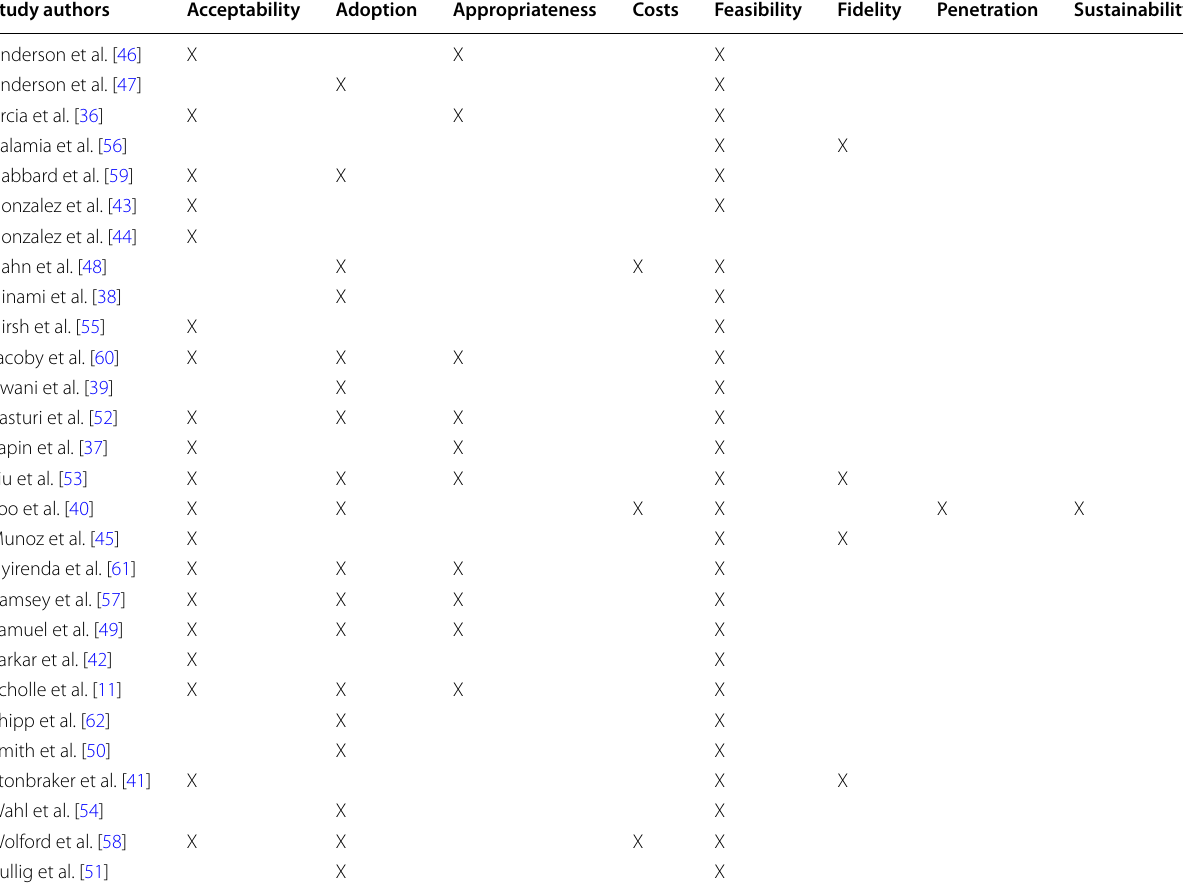
Table 3 Implementation outcomes of studies classified according to Proctor et al. [32]